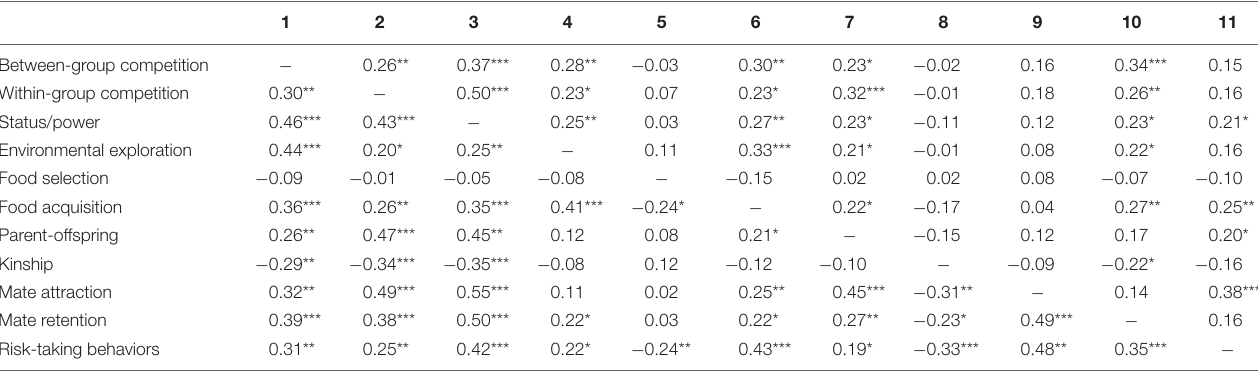
TABLE 5 | Zero-order correlations between expected benefits in the evolutionary-specific domains and risk-taking behaviors by sex.